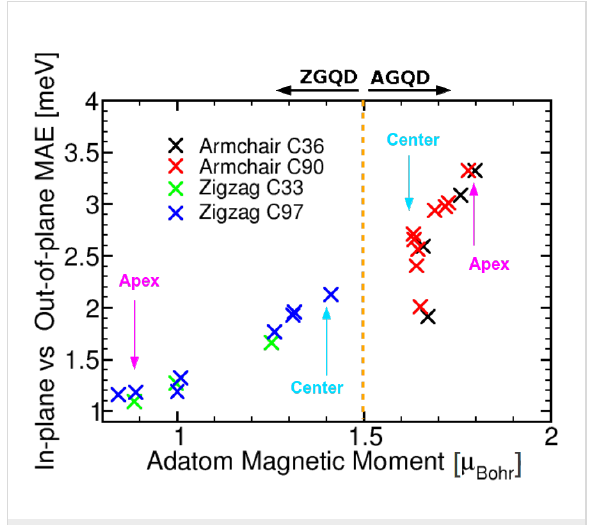
Figure 2: Correlation between the magnetic moment and the in-plane versus out-of-plane anisotropy, E IO , see Equation 1, for armchair- graphene quantum dots (AGQDs) and zigzag-graphene quantum dots (ZGQDs) consisting of 36 and 90 carbon atoms for the AGQDs, and 33 and 97 carbon atoms for the ZGQDs. Each of the points represents the spin moment and E IO for an adsorbate position of the Ru adatom. Evidently, the larger the Ru moment the greater the value attained for E IO . Specific absorbate positions (edge, apex) are indicated by the text. Note that the edge positions of the ZGQD have the lowest adatom moment (and so lowest E IO ) while, in contrast, on the AGQD these positions have the highest adatom moment and E IO . Points that deviate from the overall trend reflect a specific electronic structure associated with low symmetry positions of the